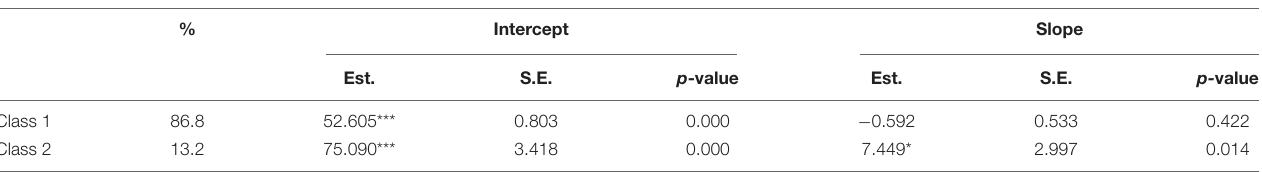
TABLE 3 | Growth parameters from 2-class innovation capacities